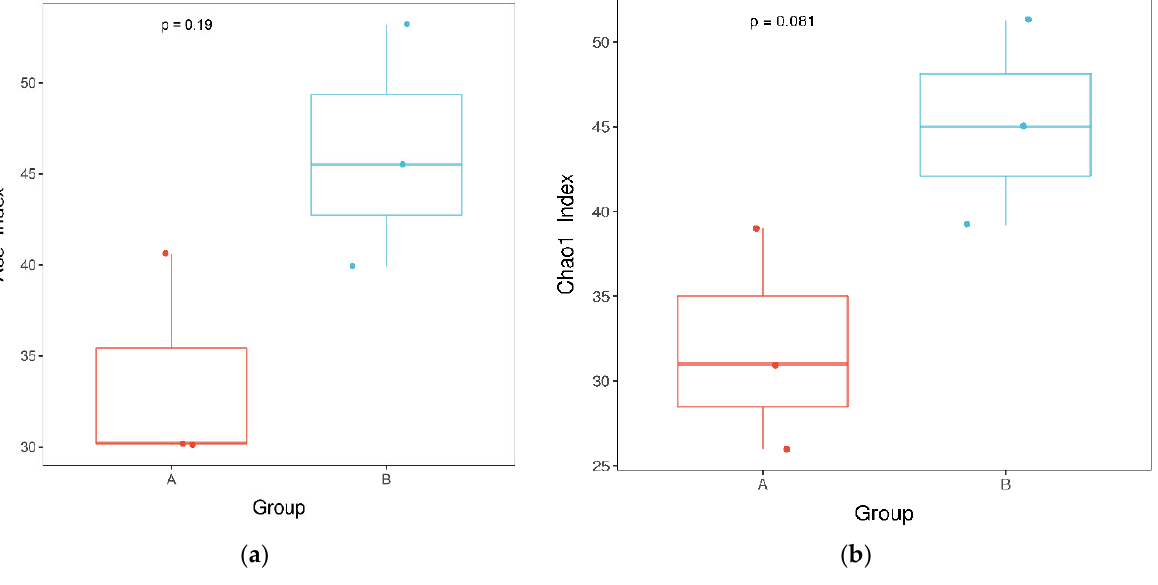
Figure 3. α-diversity of species communities in normal and mildewed post-storage fungus–seed symbiosis. ( a ) Ace index; ( b ) Chao index. Group A: unmildewed. Group B, mildewed.